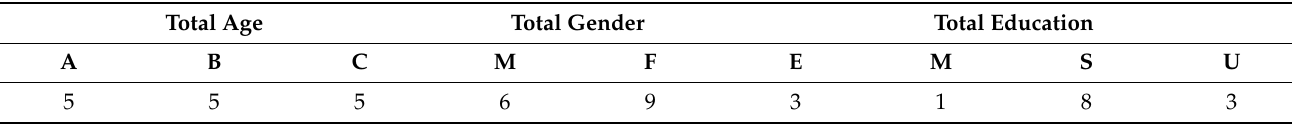
Table 1. Pool of informants after the exclusion of Subject